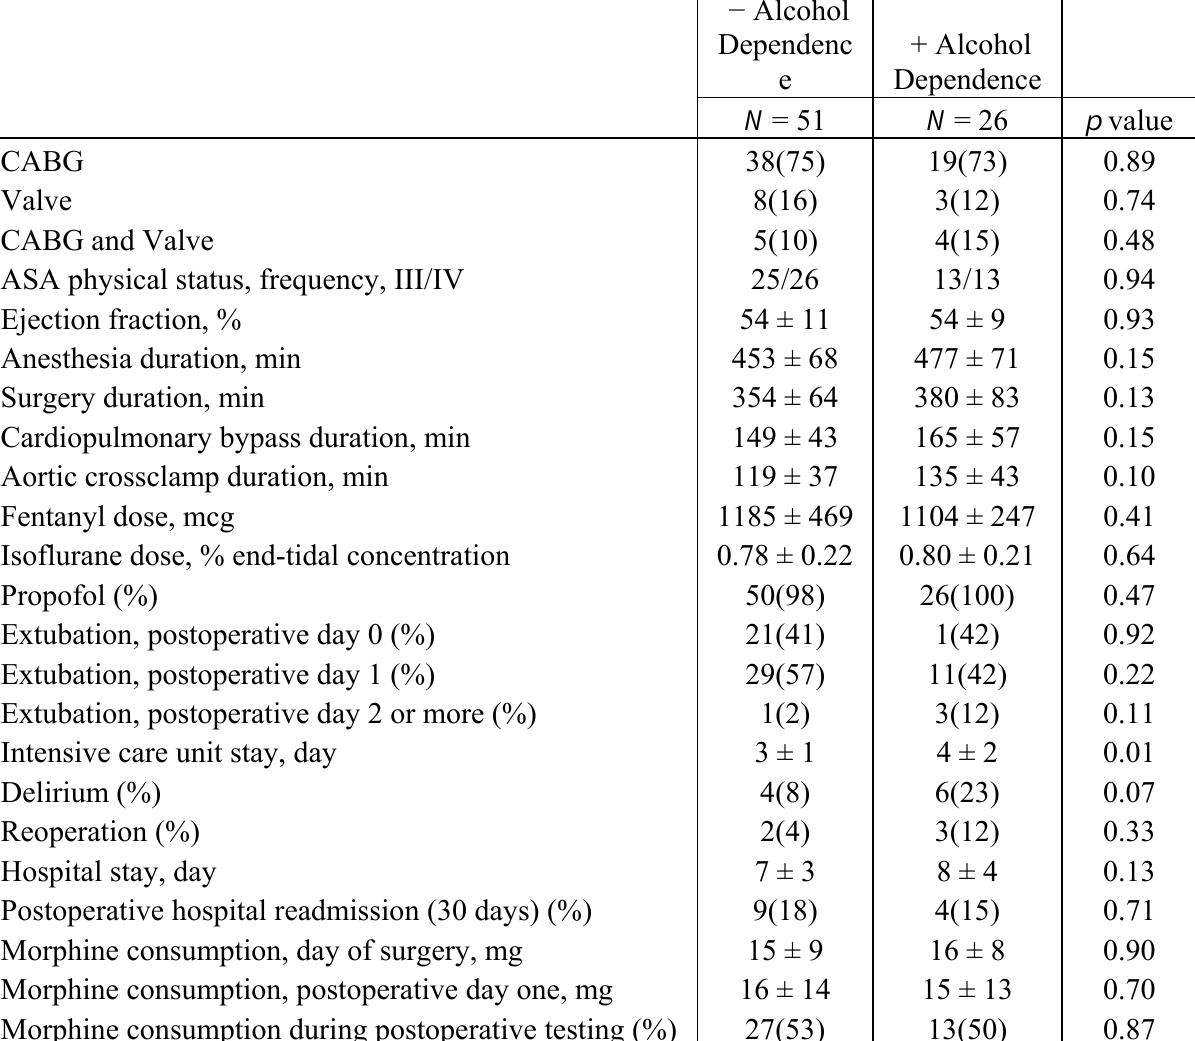
Table 2. Surgical, anesthesia, and postoperative care data in two patient groups.